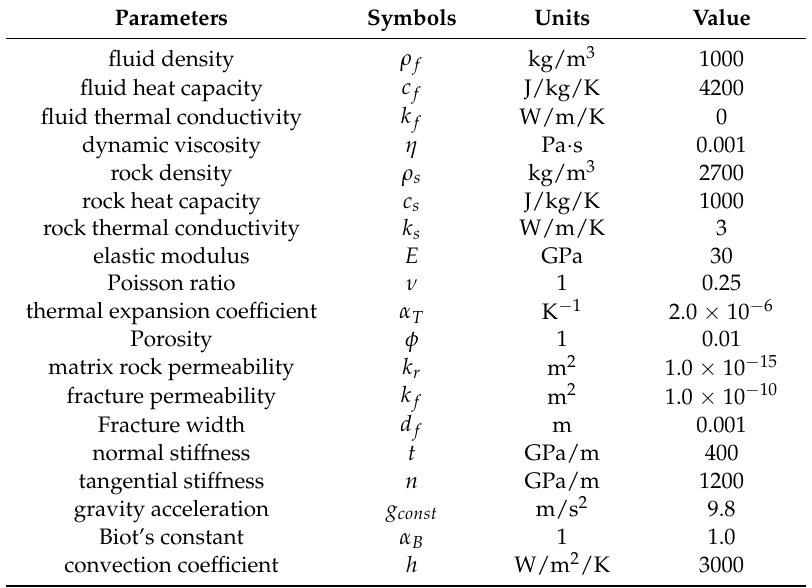
Table 2. Parameters of THM coupling effect analysis in EGS dual horizontal well